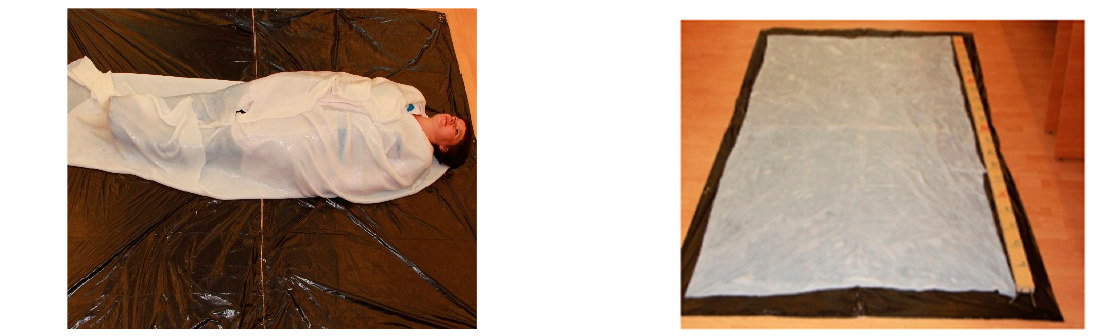
Figure 3. An adult wrapped in the BNC sheet (the ruler is 2 m long).